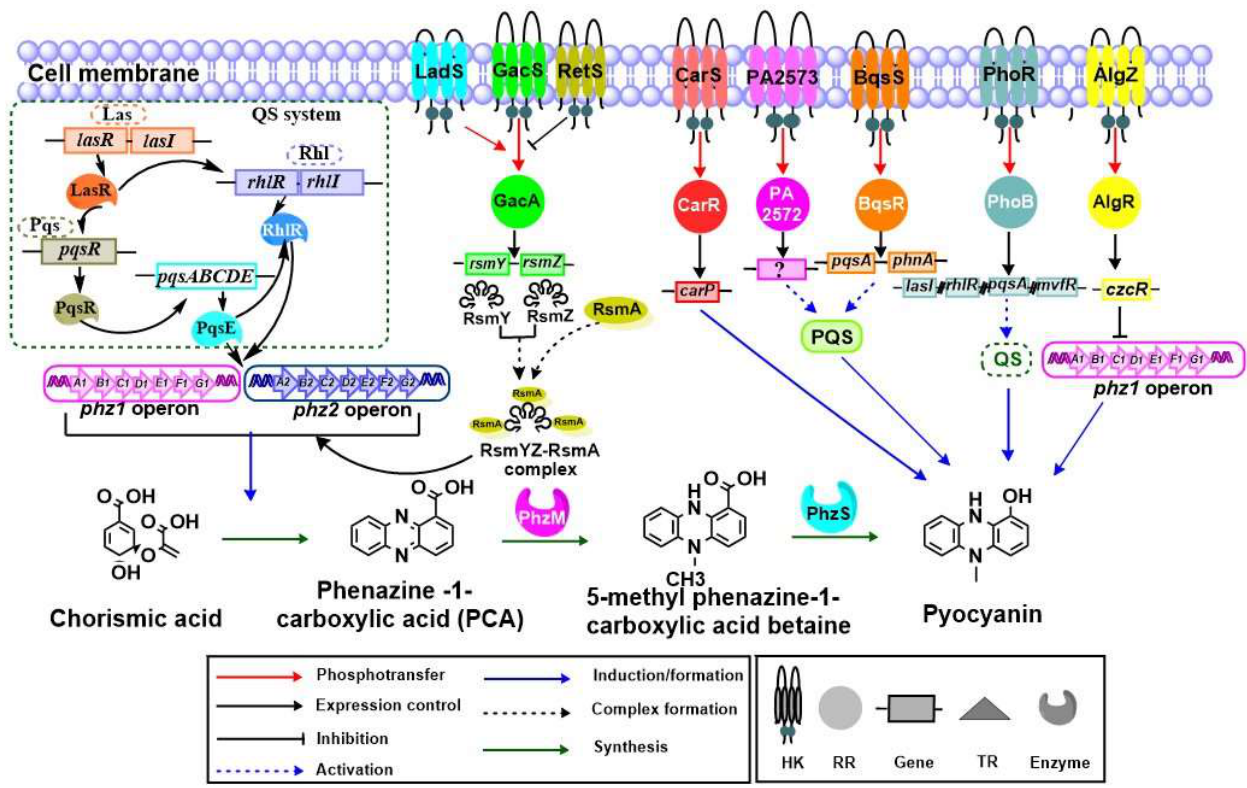
Figure 5. Biosynthesis and regulation of pyocyanin pigment by TCSs. The QS system (las, rhl, and pqs), the autoinducer synthase (PqsE), and RhlR TR are highlighted in a green dotted rectangle and play an important role in regulation of phz genes. Both phz1 and phz2 operons are responsible for biosynthesis of pyocyanin. They convert chorismic acid into phenazine-1-carboxylic acid (PCA), which is converted into 5-methyl phenazine-1-carboxylic acid betaine and finally pyocyanin pigment via phenazine enzymes (PhzM and PhzS). GacSA along with LadS and RetS hybrid HKs function in a parallel and antagonistic approach. The RsmY/Z-RsmA complex enhances the regulation of phz genes. CarSR is responsible for pyocyanin production by controlling the carP. PA2572-PA2573 and BqsSR also are responsible for pyocyanin production through PQS. PhoRB is another important TCS that is responsible for pyocyanin production through the QS network. AlgZR plays an antagonistic role in the production of pyocyanin.